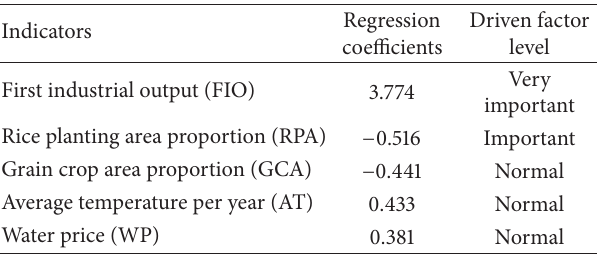
Table 10: Five major driven